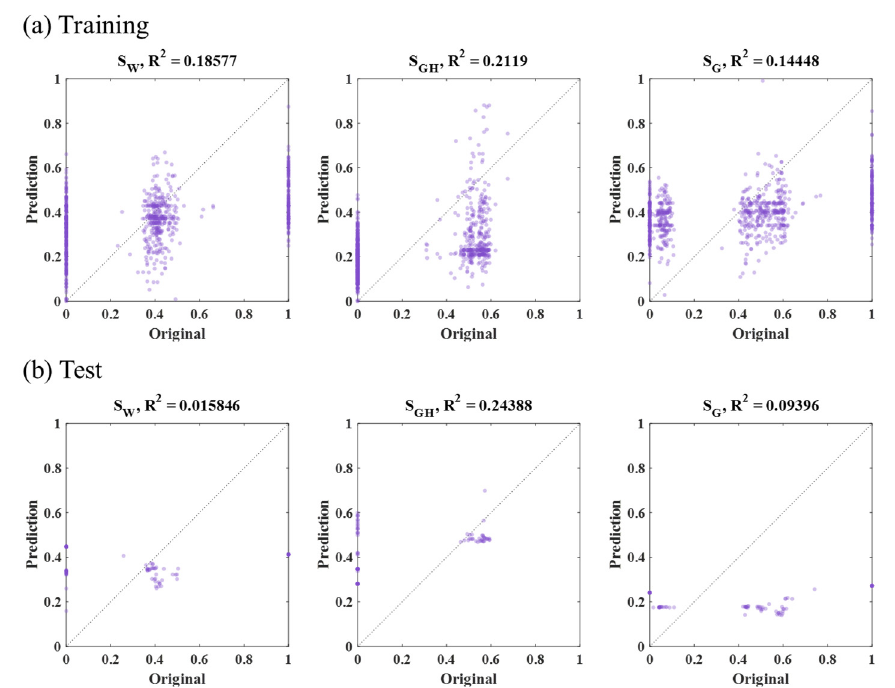
Figure 12. The training ( a ) and test ( b ) results from the CNN with the outer squared input data (Figure 8a).